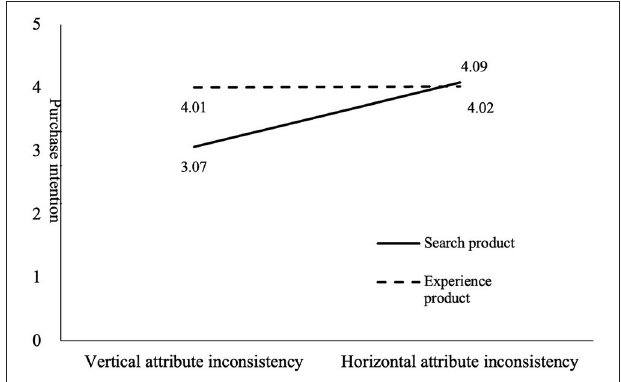
FIGURE 3 | The effect of product type on the main effect.